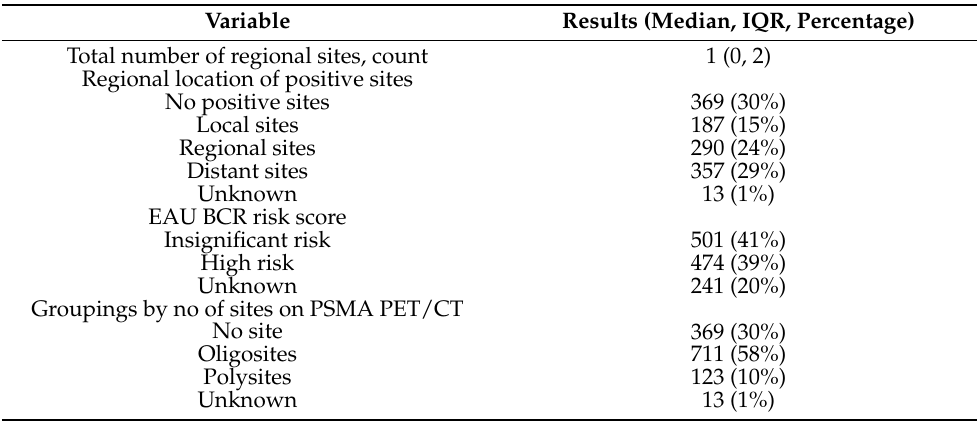
Table 2. PSMA PET